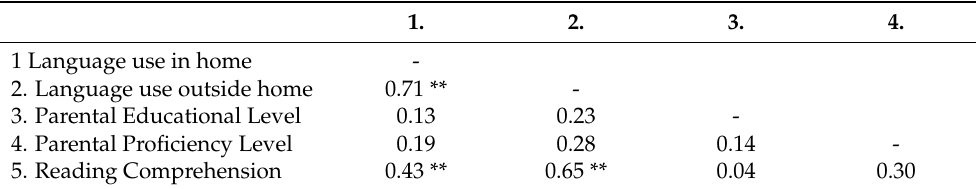
Table 7. Correlation matrix for children’s performance on reading comprehension and language use in and outside home, parents’ self-rated language proficiency and parents’ educational level in Greek.